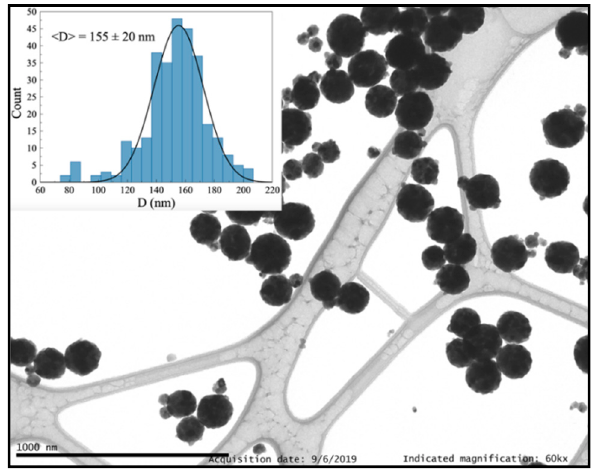
Figure 7. Y 2 O 3 : Pr 3+ nanoparticles synthesized via homogeneous precipitation using 200 mL of deionized water and 0.832 mmol of urea.